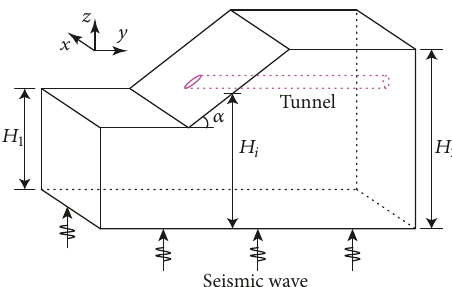
Figure 1: Input model for seismic